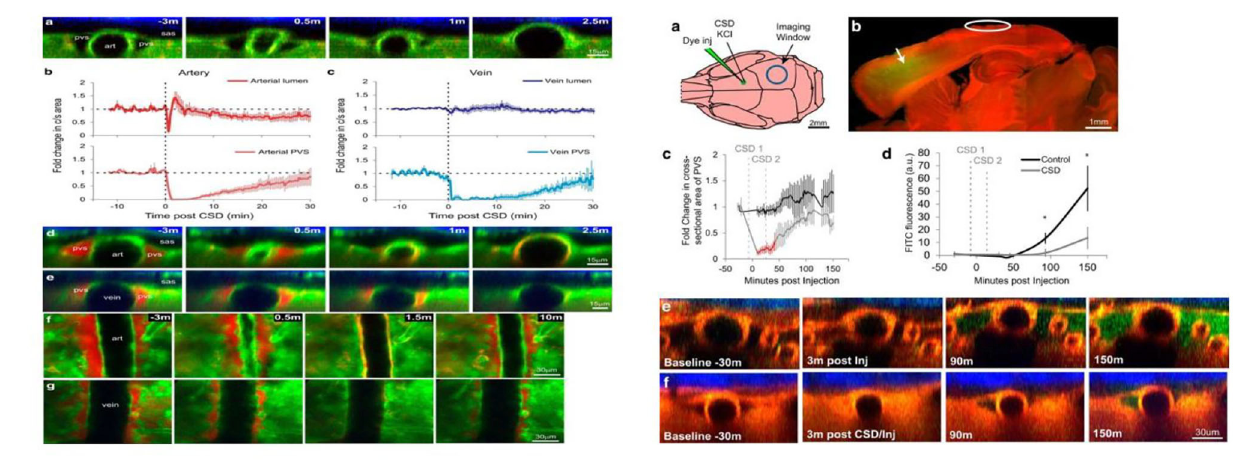
FIGURE 2 | Cortical spreading depression (CSD) closes perivascular spaces (PVS), which impairs glymphatic flow, during migraine (11). The left panel illustrates the closure of the para-arterial space and para-venous space caused by the CSD over time in vivo two-photon. Specifically, the para-arterial and para-venous spaces close for 6 and 16min, respectively, and partially reopen at 30min, which causes the impairment of glymphatic flow that is represented in the right panel. The glymphatic flow over time (green dye) in CSD mice (right f) is lower than that in controls (right